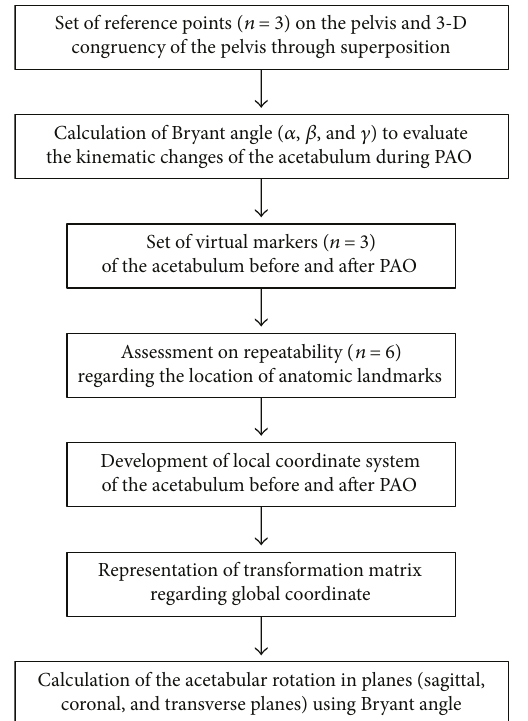
Figure 1: Flow chart for three-dimensional rotational calculation of the osteotomized acetabulum during